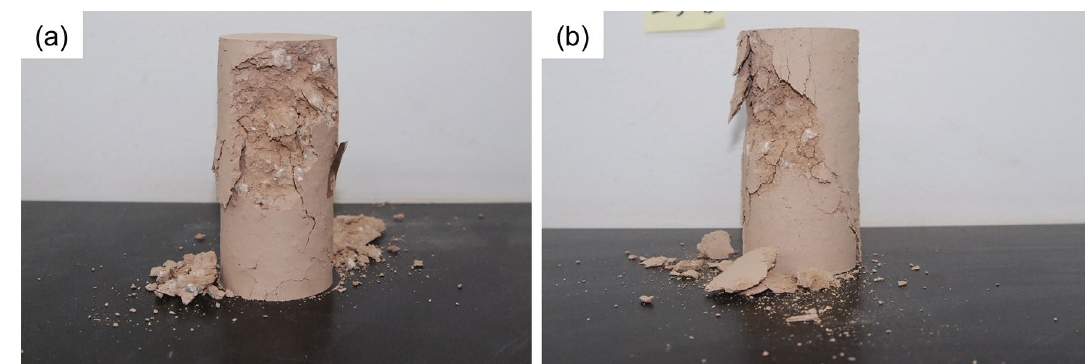
Figure 8. Photographs of failure planes in ( a ) S-6E and ( b ) S-7d passing around breccia after unconfined compression